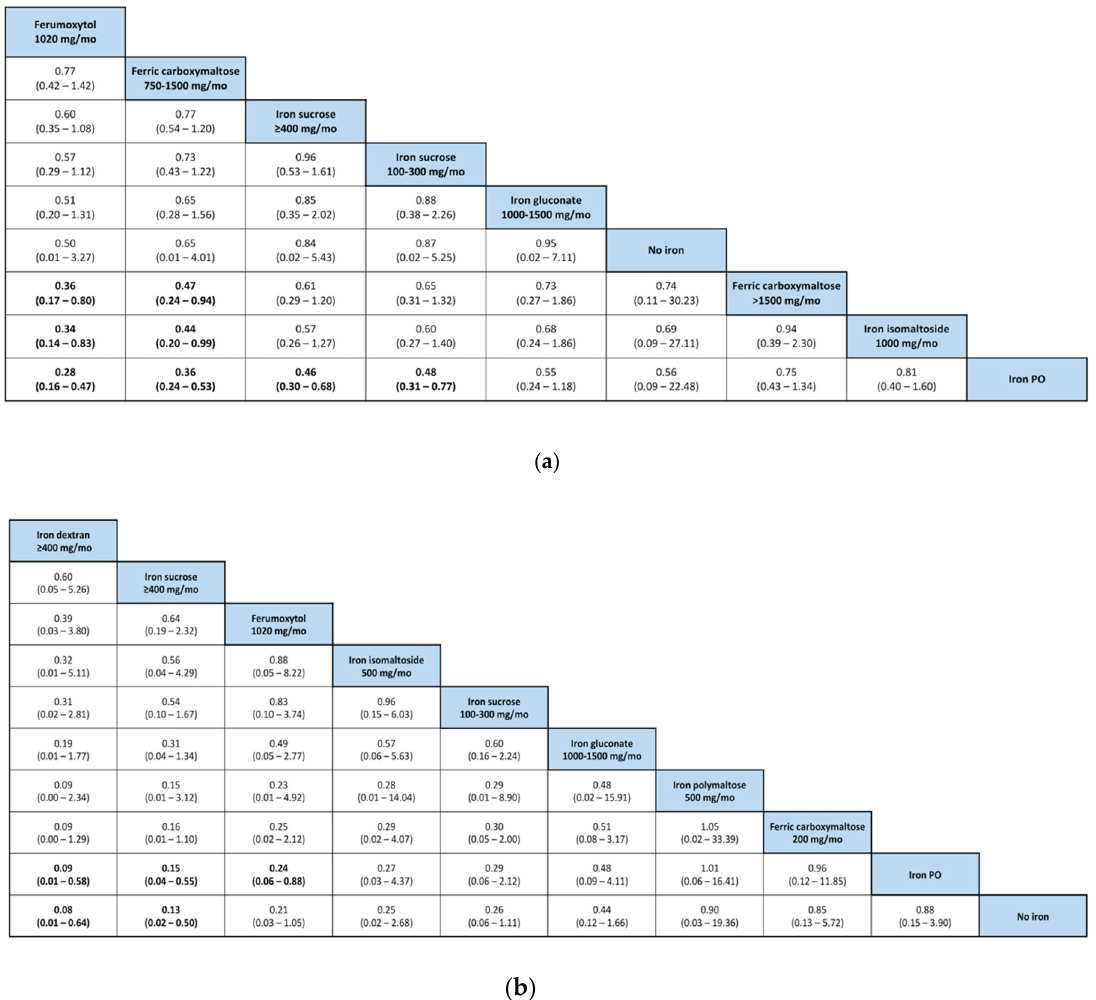
Figure 4. League tables showing ORs and 95% CrIs corresponding to the assessed IV iron supplements against the comparators in the subgroups of ( a ) patients in the KDIGO GFR categories 3A to 5, and; ( b ) dialysis patients. CrI, credible intervals; OR, odds ratio. Table 1. SUCRA-based ranking of iron supplements evaluated. Iron Supplements